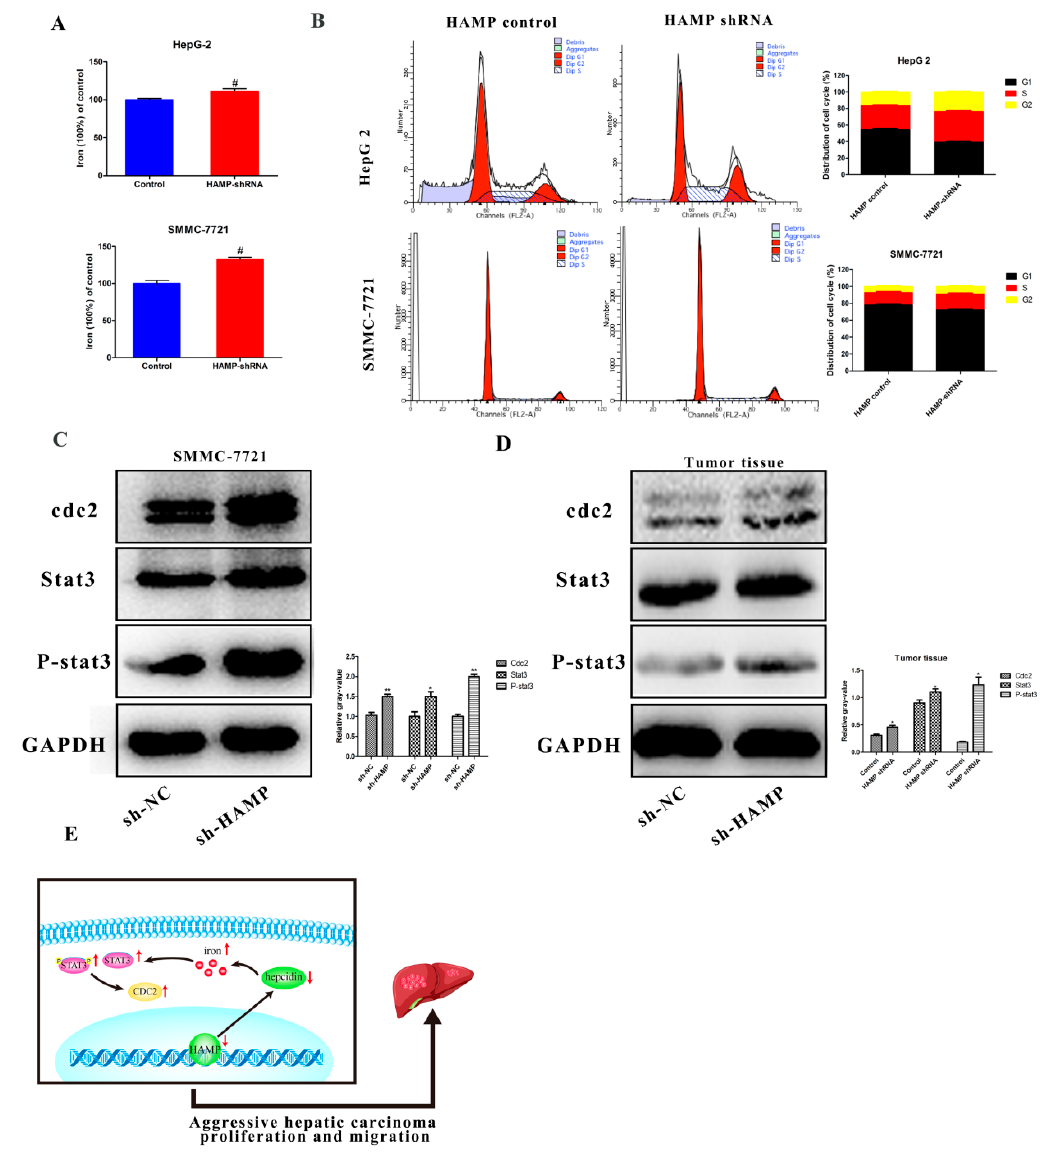
Figure 6. HAMP downregulation activates the cdk1 / stat3 pathway. ( A ) Knockdown of HAMP promotes cellular iron concentration in SMMC-7721 / HepG-2 cells. ( B ) Cell cycle analysis of SMMC-7721 and HepG-2 cells transfected with HAMP shRNA. ( C , D ) HAMP downregulation activates the cdk1 / stat3 pathway. ( E ) Downregulation of HAMP low expression of hepcidin, which promotes cellular iron concentration and then activates the cdk1 / stat3 pathway to promote tumor proliferation and metastasis. # p < 0.05, * p < 0.05 and ** p < 0.01.